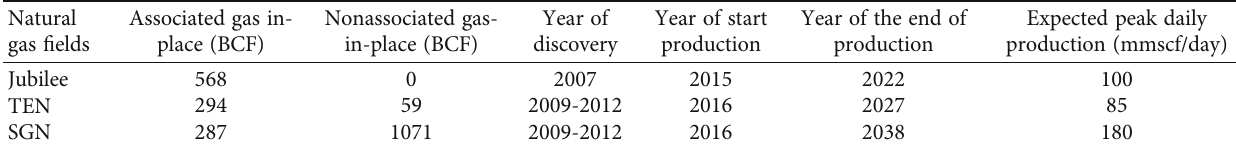
Figure 4: Existing and potential hydropower sites in Ghana [80]. Table 3: Natural gas discoveries and reserves